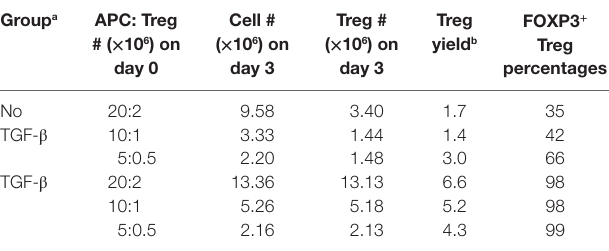
TaBle 1 | Regulatory T cells (Tregs) exhibit stable expansion in the presence of exogenous TGF- β , IL-2, and